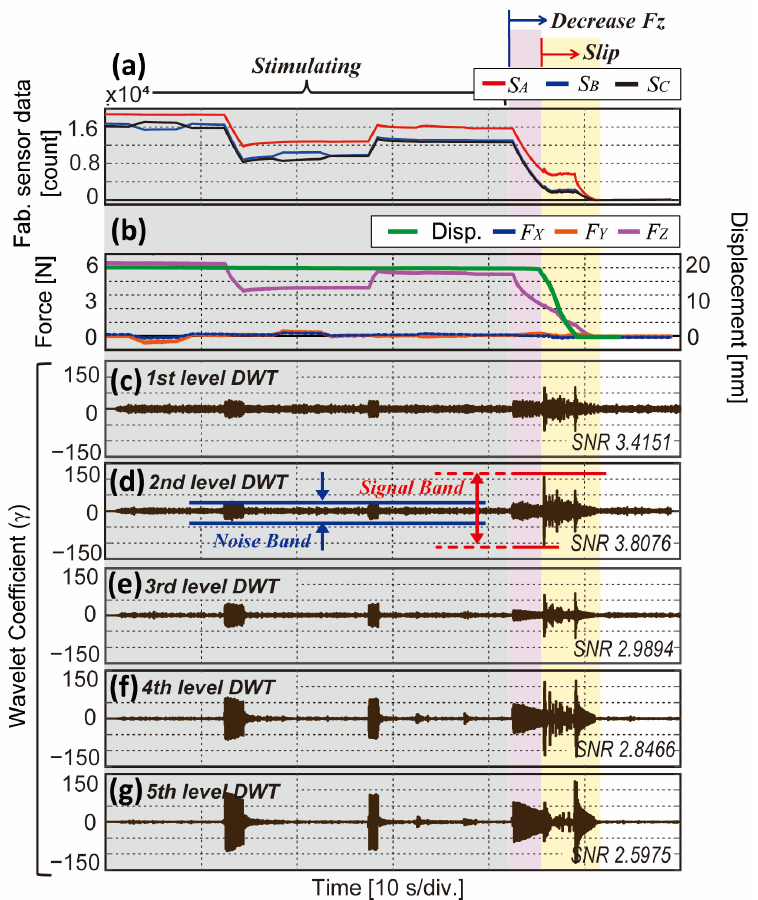
Figure 8. Experimental results of slip detection in different DWT levels. Red area indicates stimu- lating period with random three-axis forces and yellow area indicates slip. ( a ) Fabricated sensor data from each BPSC. ( b ) Three-axis forces and displacement from reference sensor. ( c – g ) DWT results in the 1st to 5th level with SNR value.